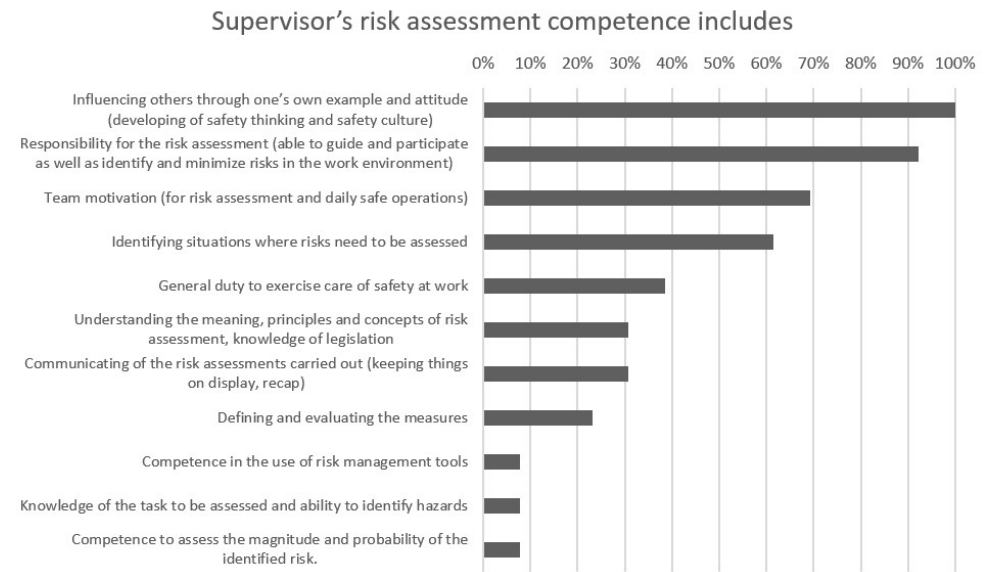
Figure 2. Opinions of occupational health specialists and managers on the most important risk assessment skills needed by the supervisor